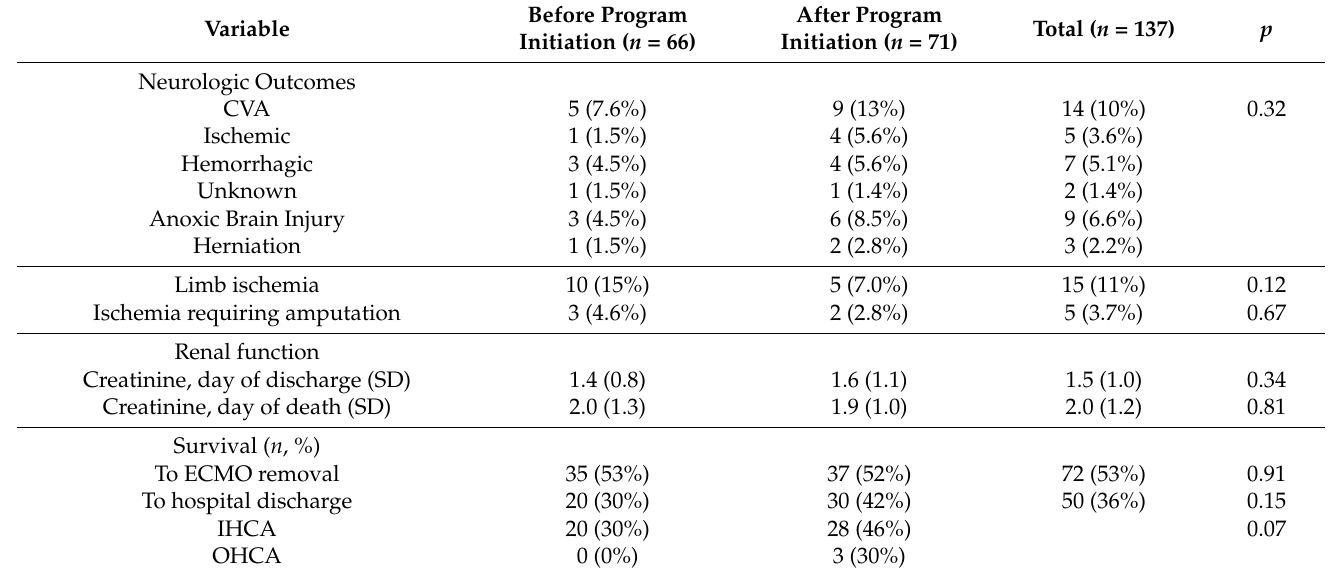
Table 3. Associated Morbidity and